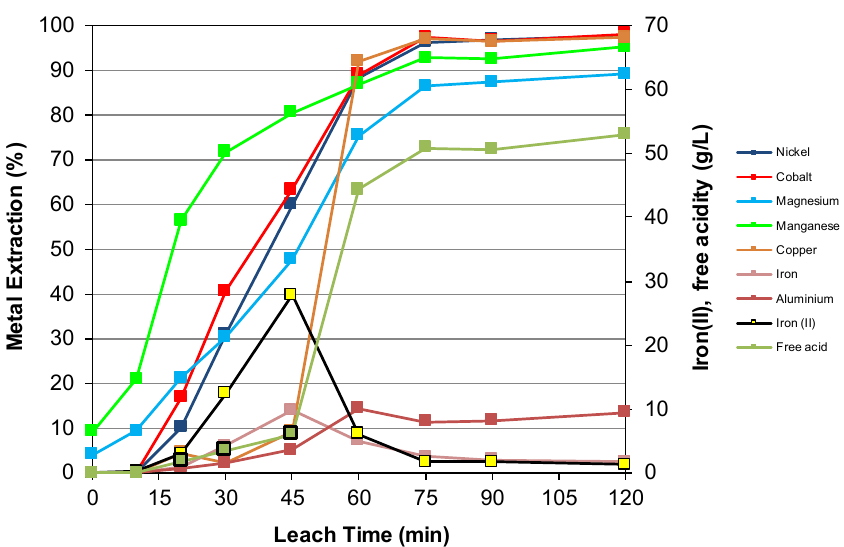
Figure 5. Metal extractions, ferrous iron concentration and free acidity for samples taken during the co-processing of 40% w / w total, 12.0% nickel concentrate with 28.0% nickel laterite ore, in site water at 250 °C with ~250 kPa O 2 overpressure.